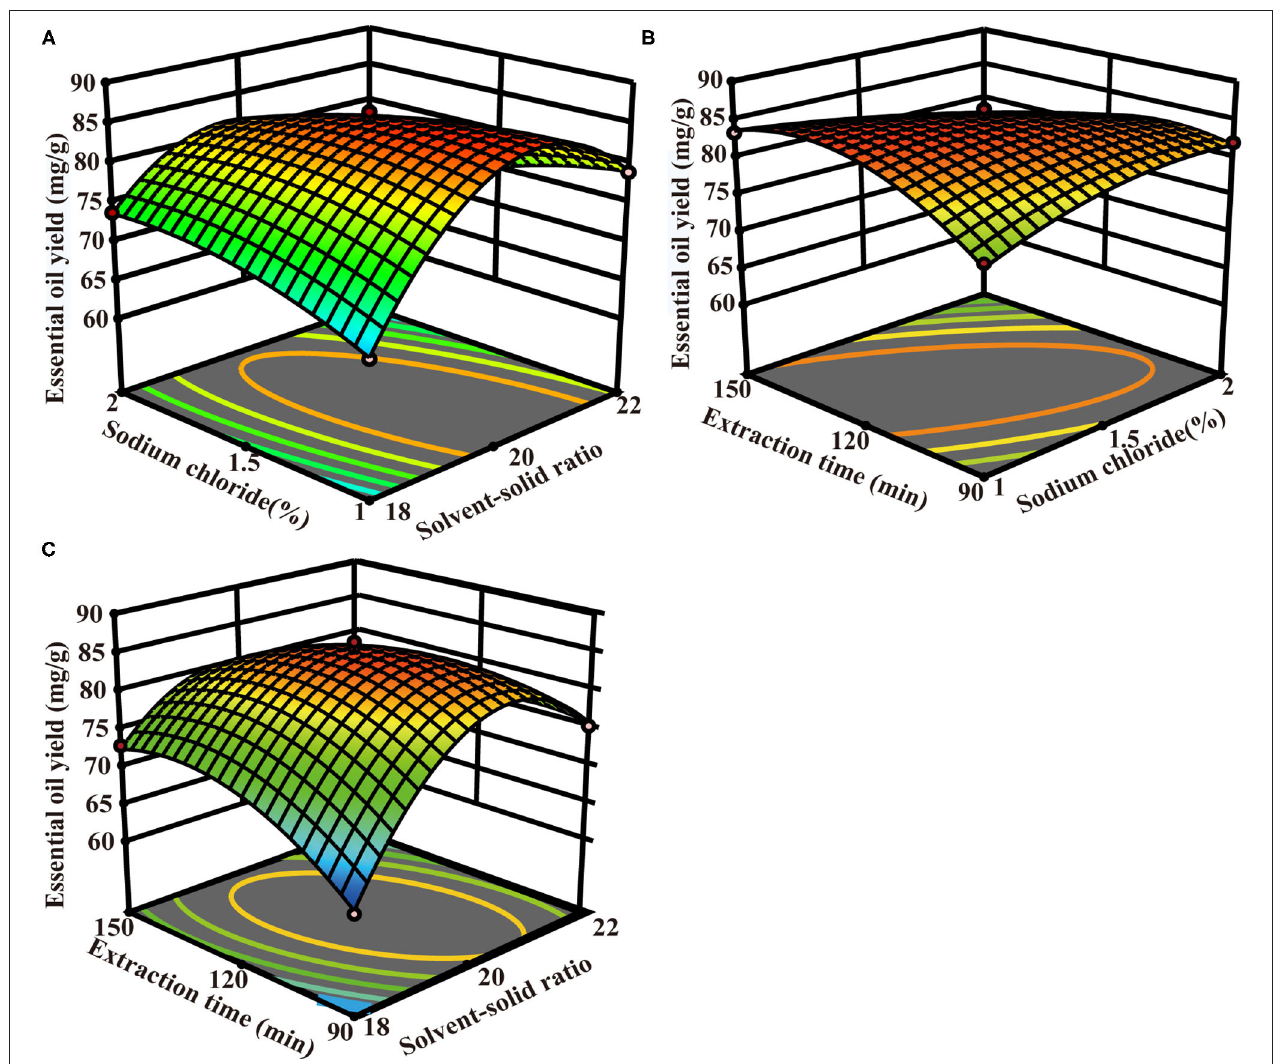
FIGURE 3 | The optimization of the HD extraction process. (A) The interaction of solvent-solid ratio and sodium chloride concentration; (B) the interaction of sodium chloride concentration and extraction time; (C) the interaction of solvent-solid ratio and extraction time.